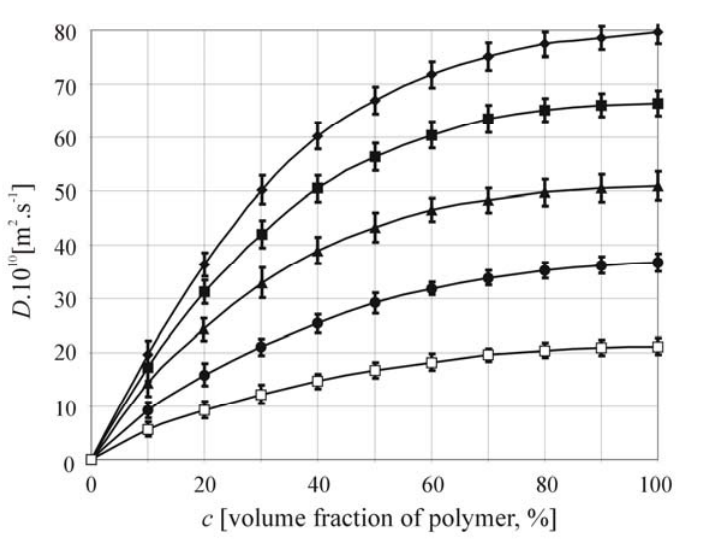
Figure 4. The Comparison of mutual diffusion coefficient dependent on concentration of hyaluronan (M = 50,28kDa) for five temperatures (diamonds-T = 45 w